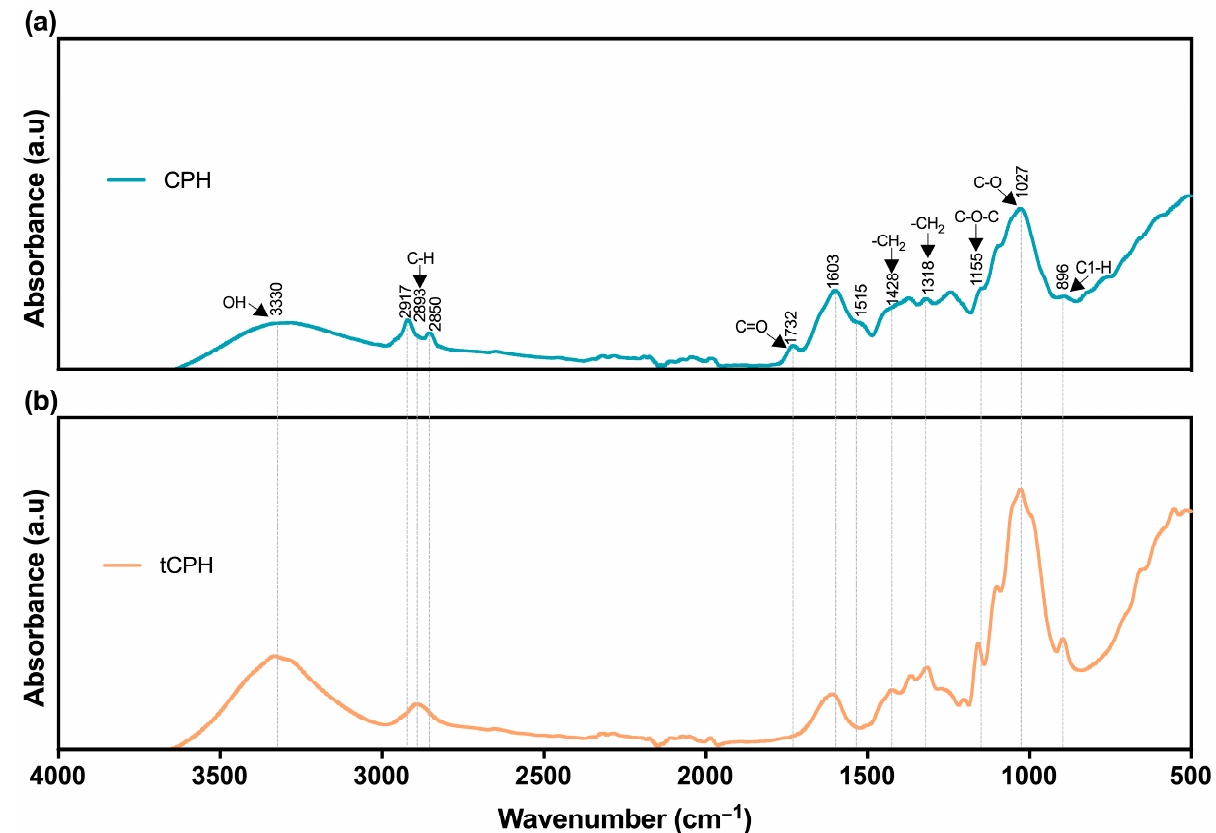
Figure 2. FTIR spectrum of ( a ) CPH fiber and ( b ) tCPH fiber .